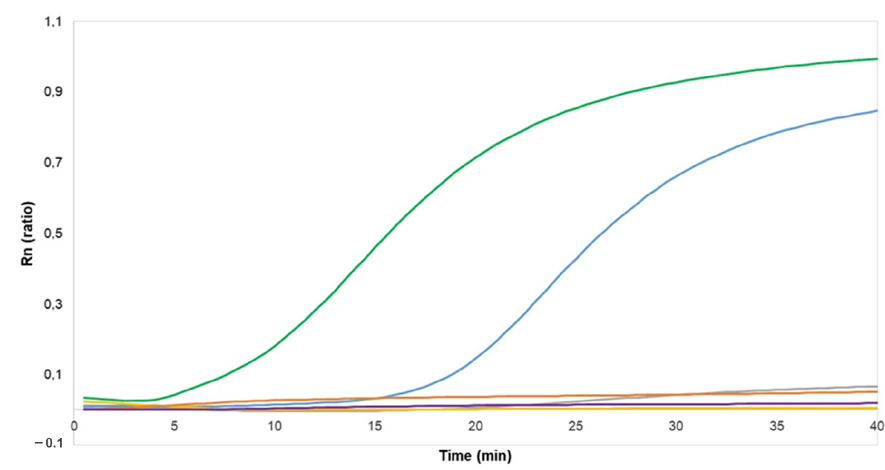
Figure 1. Real-time HBV RPA Exo test for primer screening. Extraction of the HBV standard sample with a viral load of 1 × 10 6 IU/mL was carried out with 5% Chelex 100. Green line: HBV-Fc/P1R-HBV primer combination; blue: P1F-HBV/P1R_HBV; grey: HBV-Fc/HBV-R1; orange: P1F-HBV/R1-HBV; purple: non-template control; yellow: dH 2 O. Rn corresponds to the ratio of FAM (6-carboxyfluores- cein) to ROX (carboxyrhodamine) fluorescence.